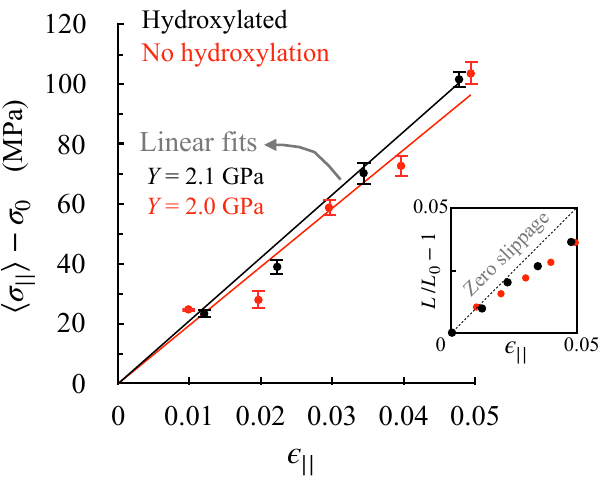
Figure 4. Effect of de-hydroxylation on axial stress–strain relationship. The data points are obtained from constant-strain ( (cid:101) || ) MD simulations of the fibril. (cid:104) σ || (cid:105) − σ 0 is the stress that builds up along the fibril axis, and the standard errors are obtained by block averaging. The inset shows the effect of strain on monomer end-to-end distance ( L / L 0 − 1), where L 0 is the length of the monomer under zero-strain conditions. The standard deviations in L / L 0 are small (reported for L 0 in Table 1) and are, therefore, not